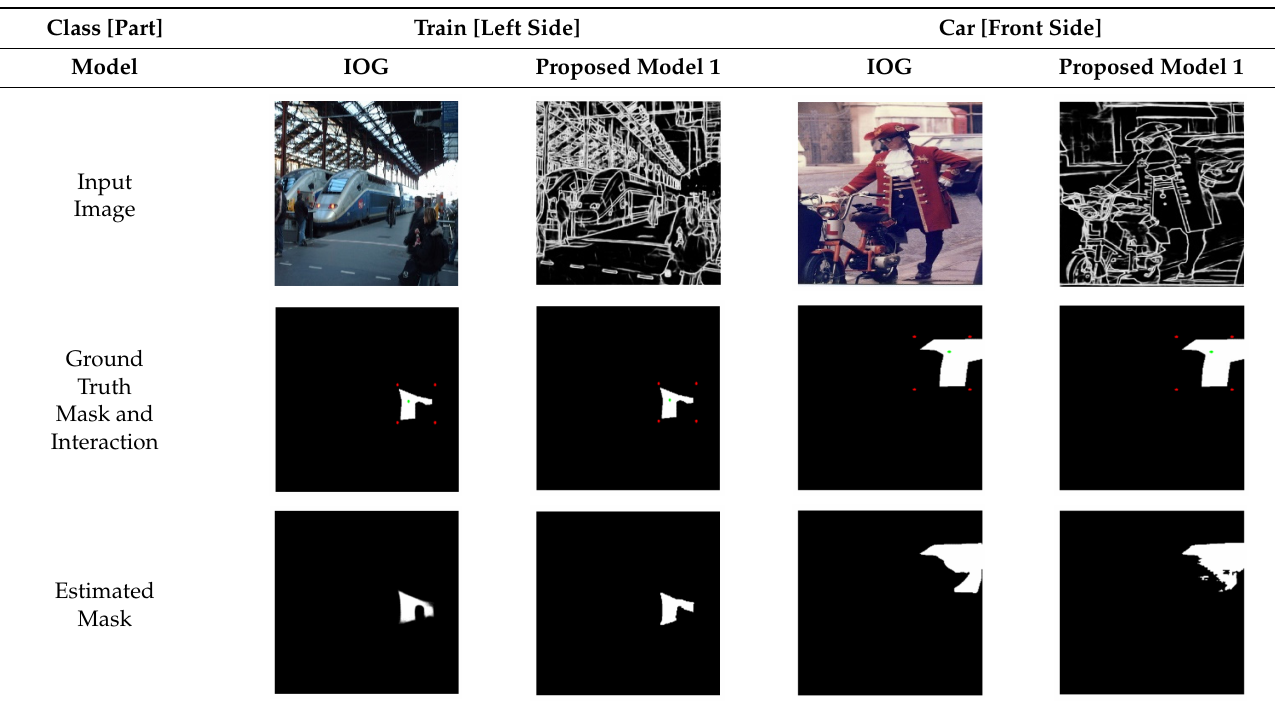
Table 9. The estimated masks of parts from the IOG model and proposed model